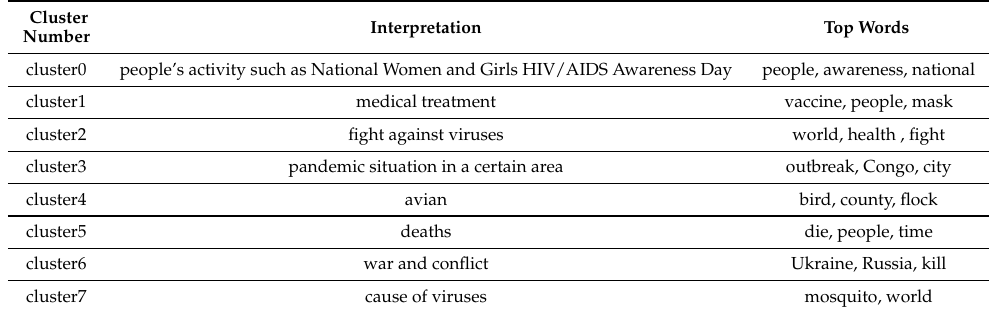
Table 2. Interpretation of clustering on FastText.